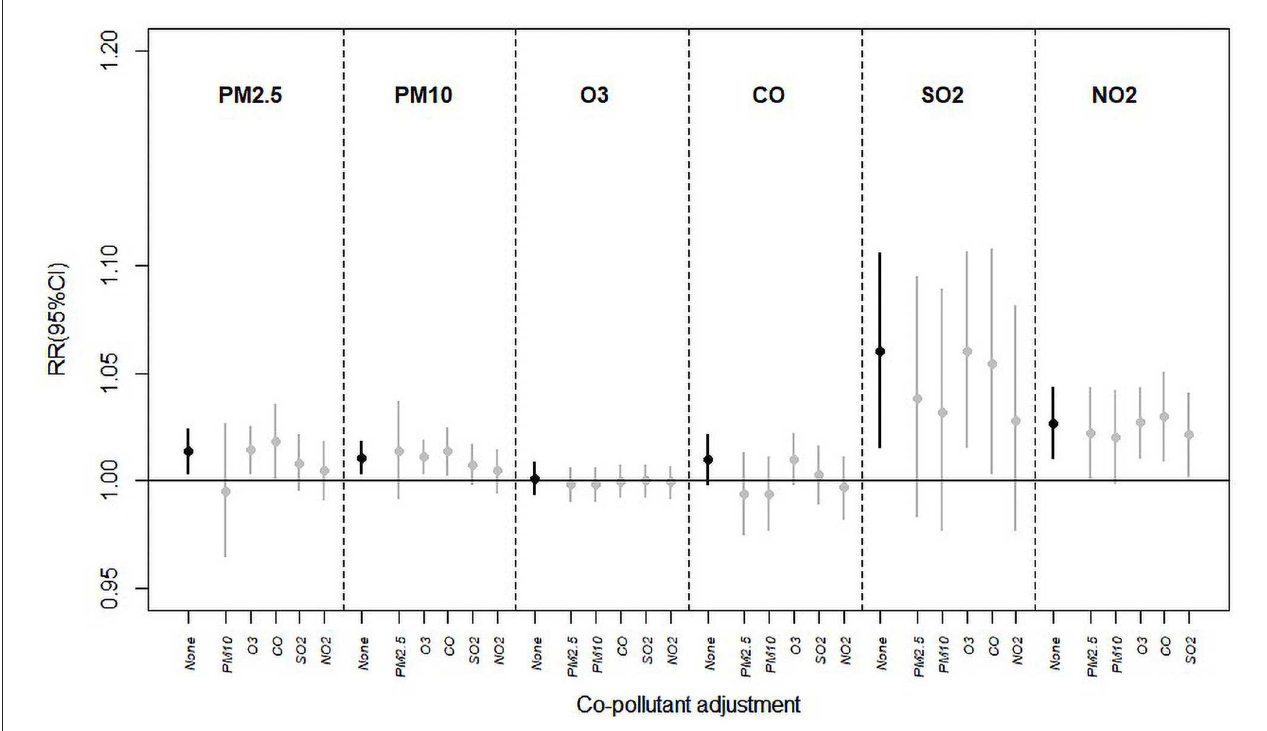
FIGURE3 Estimated RR (Rate ratios) and 95% CIs (confidence intervals) in the single- and two-pollutant models with adjustment for PM 2.5 , PM 10 , O 3 , CO, SO 2 , and NO 2 on lag0 for hospital admissions for pneumonia and